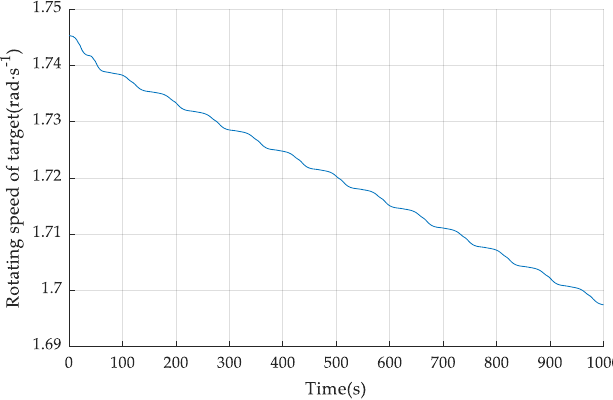
Figure 18. Target speed curve after torque enhancement.